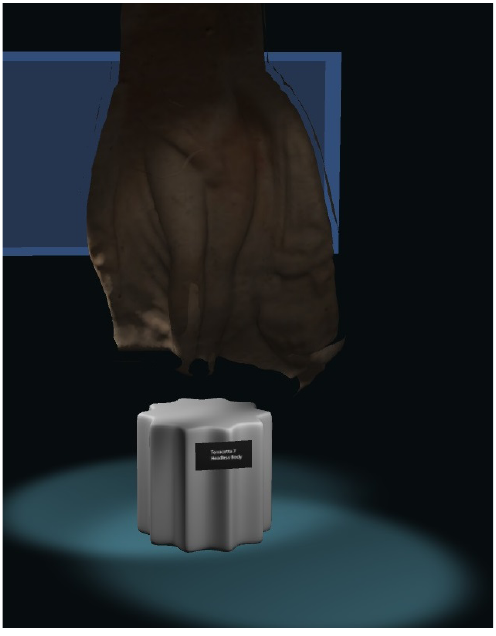
Figure 2: Virtual reality view of a terracotta figurine representing Aphrodite.